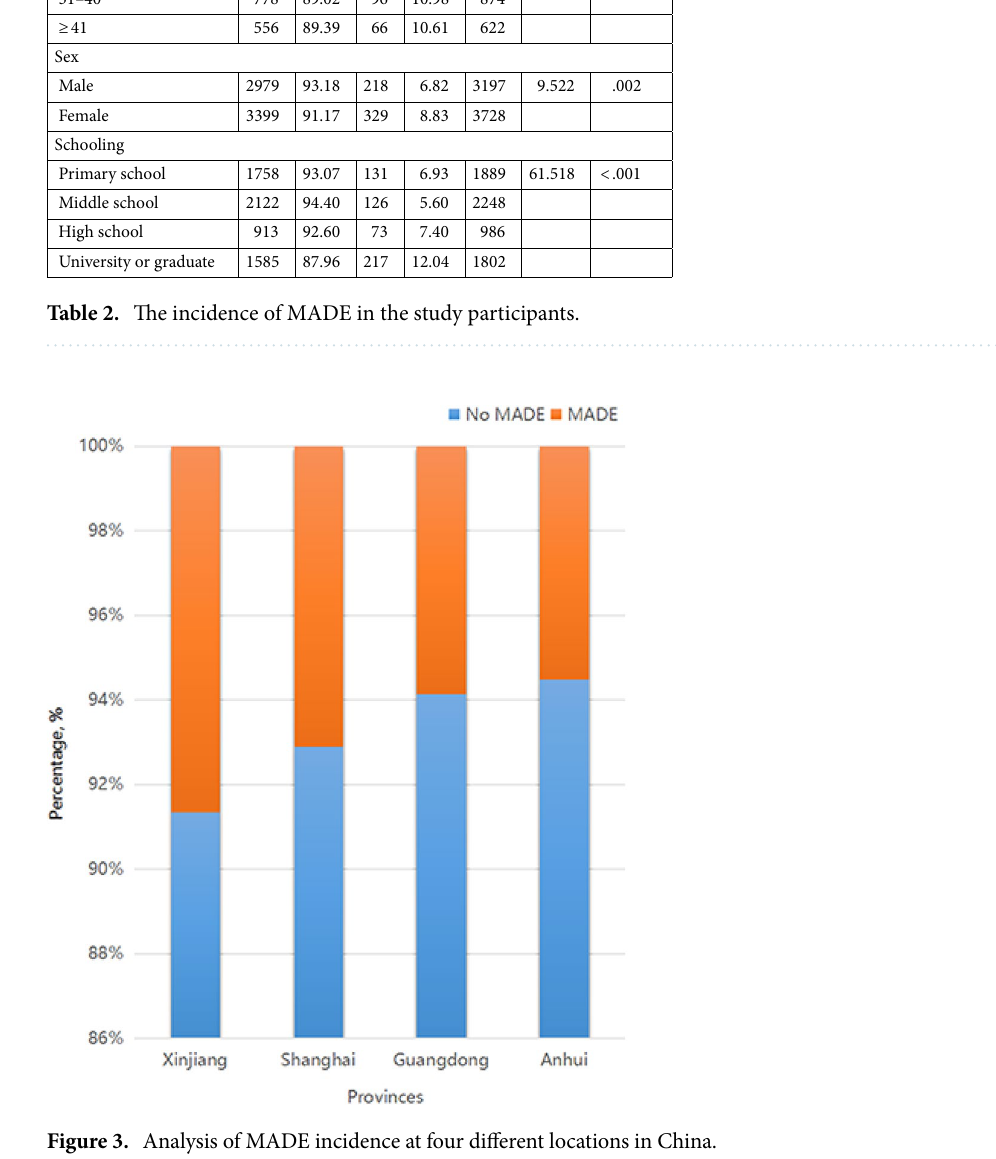
Figure 3. Analysis of MADE incidence at four different locations in